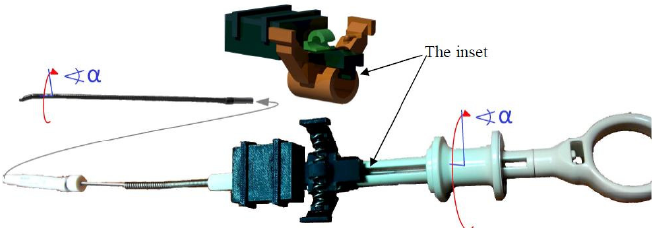
Figure 6. The concept of measuring the rotation angle of the guide handle based on the IMU type sensor.